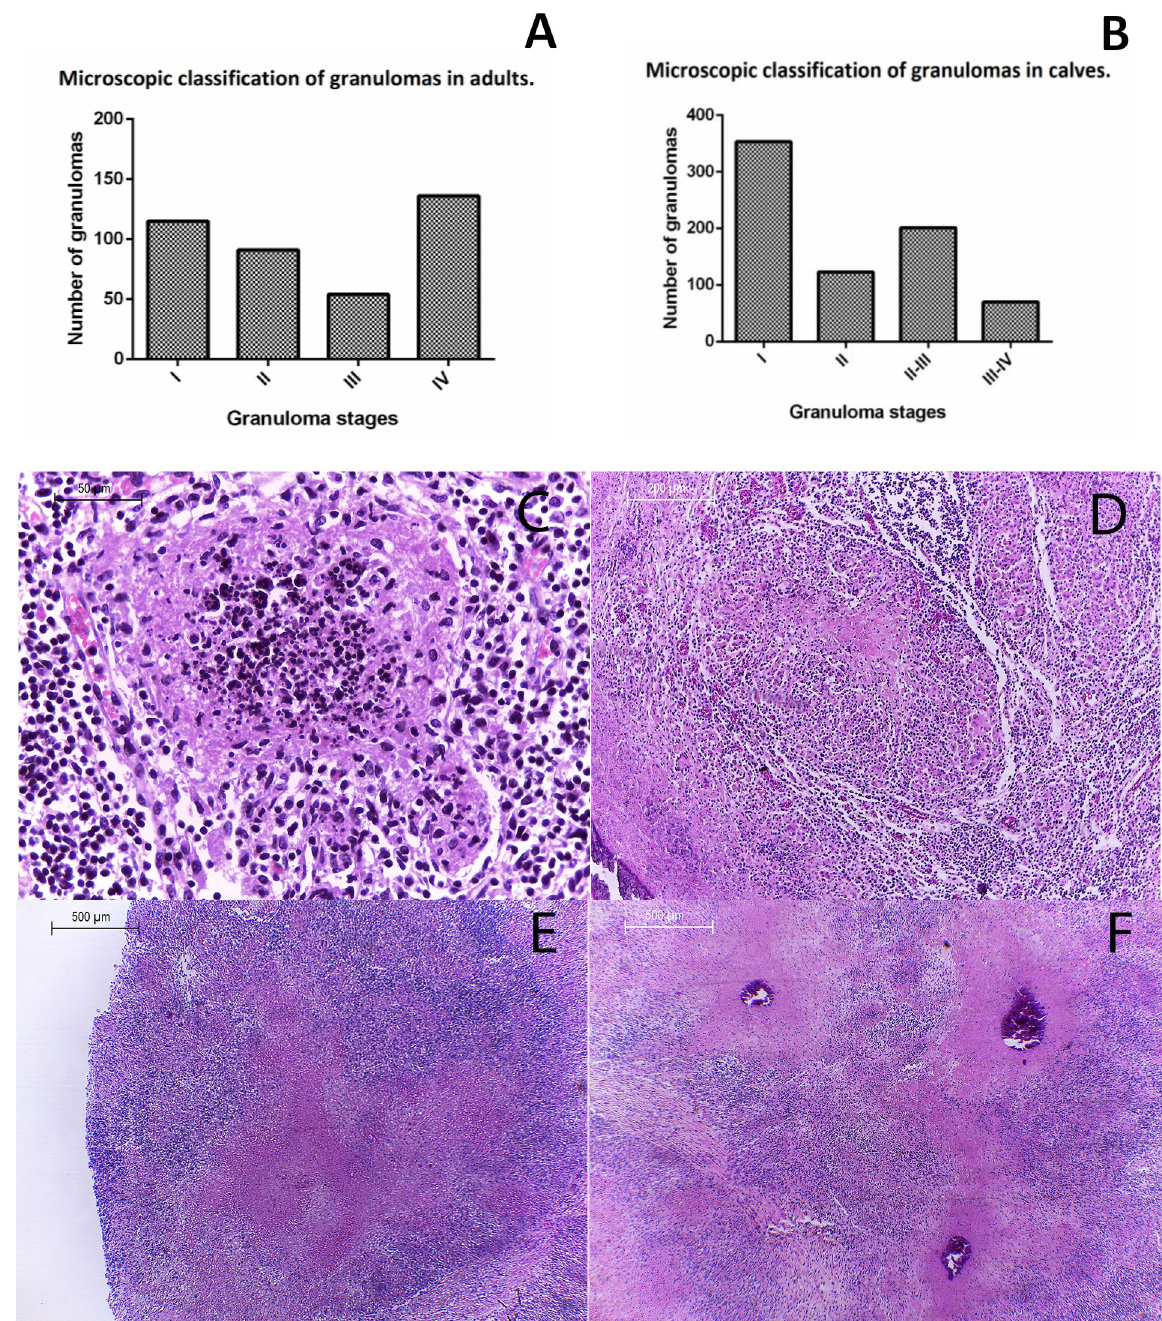
Fig 4. Histopathological classification of granulomas found in lymph nodes from calves four months of age or younger. (A) Graph of granuloma stages identified in adults, showing a higher frequency of stages I and IV. (B) Graph showing a higher frequency of stage I granulomas in calves. H&E ( C) Stage I: 400X, small diffuse foci of infiltrated inflammatory cells, mainly macrophages, epithelioid macrophages and abundant cellular detritus at the center of the lesion. (D) Stage II: 200X, Larger structure with epithelioid macrophages, multinucleated giant cells, cell debris and necrosis. (E) Stage II-III: 40X, large necrotic areas without borders, absence of connective tissue capsule or lymphocyte accumulation in the periphery. (F) Stage III-IV : 40X, lesions showing extensive necrotic areas, mineralization and cell debris without defined borders, surrounded by macrophages, absence of connective tissue capsule or lymphocytes in the periphery; lesions tend to coalesce and fuse.